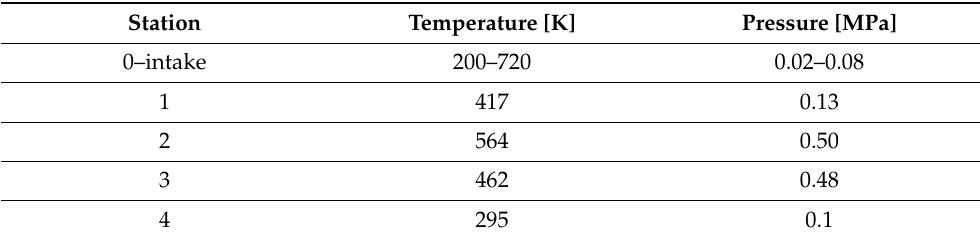
Table 1. ECS flow characterization